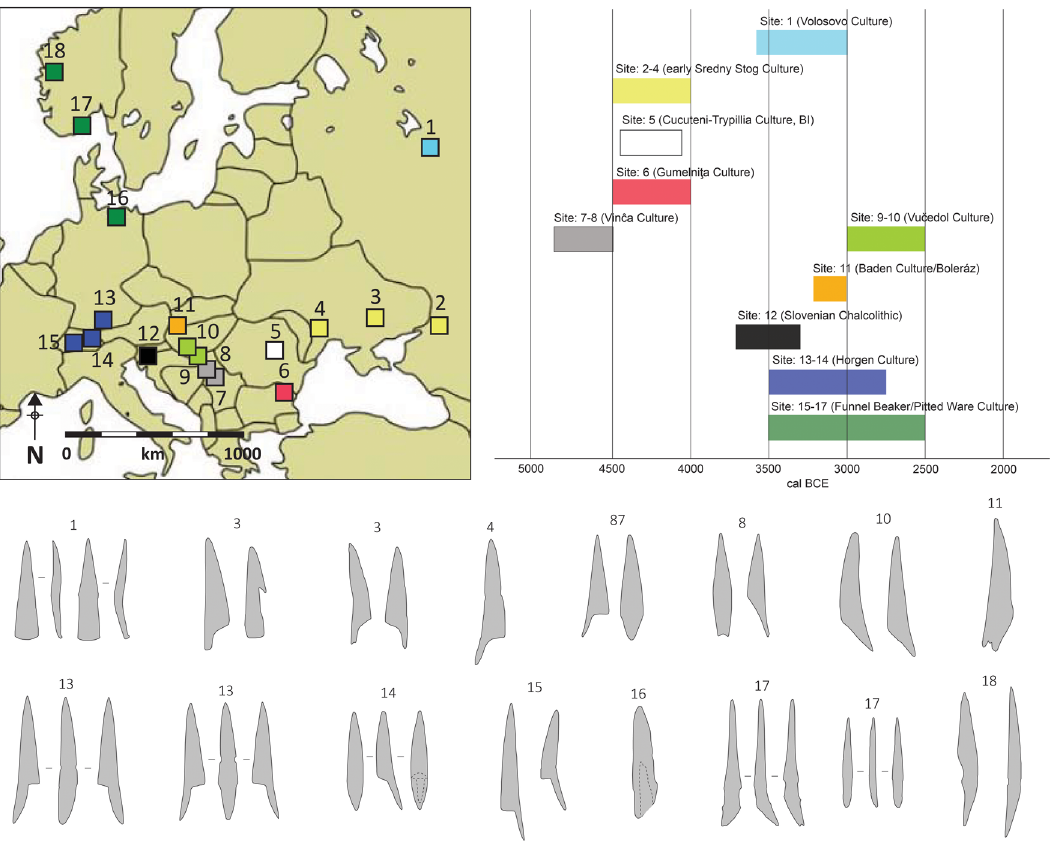
Figure 6: The distribution of Neolithic sites with toggling harpoons in Europe and their associated chronological phases. Sakhtysh II ( 1 ) , Razdorskoye I ( 2 ) , Sredny Stog and Strilcha Skelya ( 3 ) , Soroki I ( 4 ) , Malna ş - B ă i ( 5 ) , Pietrele and Vit ă ne ș ti - M ă gurice ( 6 ) , Divostin and Drenovac ( 7 ) , Vin ĉ a - Belo Brdo and Jakovo - Kormadin ( 8 ) , Sarva š - Gradac ( 9 ) , Zók ( 10 ) , Gyor - Szabadret - domb ( 11 ) , Ljubljana marshes ( 12 ) , Lake Federsee ( 13 ) , Siedlung Forschner, Dullenried, Wasserburg Buchau, Zurich - Alpenquai, and Steinhausen - Sennweid, ( 14 ) , Nidau - Steinberg and Auvernier ( 15 ) , Ostorf - Tannenwerder ( 16 ) , Jortveit ( 17 ) , and Skipshelleren ( 18 ) . See the main text for site references. The timespan presented in colour for each region re fl ect the age of radiocarbon dated contexts and artefacts, and for further details see the main text. Example drawings of harpoons from selected sites are based on published illustrations and have been scaled approximately. Figure by Svein V.